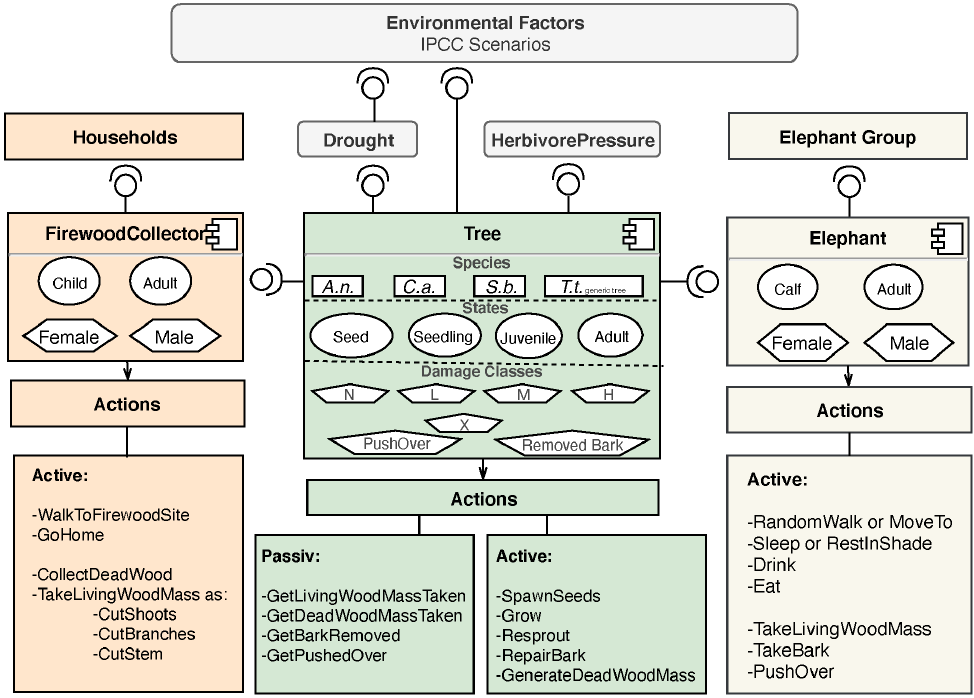
Figure 3. Conceptual model of the implemented ABM. Each of the three agent types, FirewoodCol- lector, Tree, and Elephant, is defined by a set of attributes and equipped with a set of active and/or passive actions. A FirewoodCollector is associated with a Household, while an Elephant is associated with an Elephant Group. Trees are interfaced with EnvironmentalFactors and a HerbivorePressure component. These external forces, along with disturbances by FirewoodCollectors and Elephants, impact the state of Trees in the ABM. For more details, see Appendix